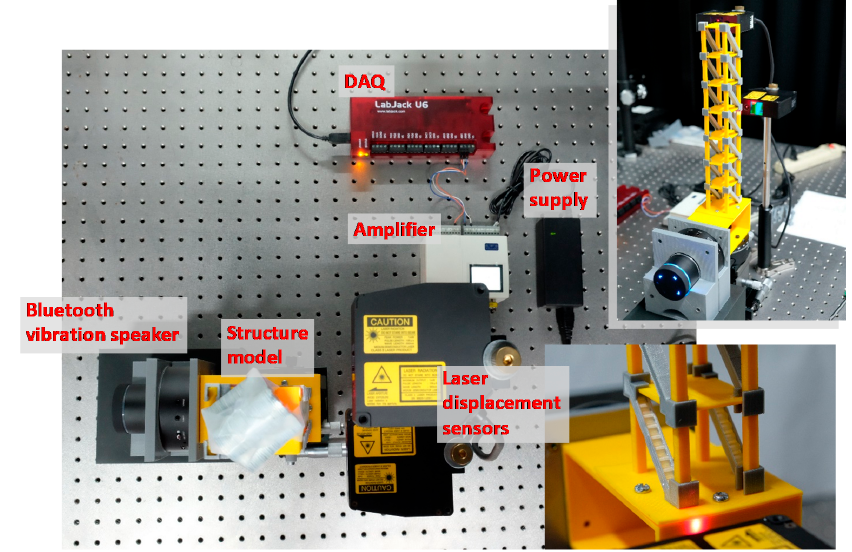
Figure 3. The experimental setup. The specimen was printed by the 3D printer. A Bluetooth vibration speaker was used to excite the specimen, and two laser displacement sensors were used to